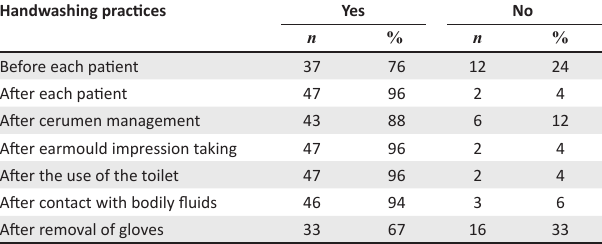
TABLE 4: Participants’ handwashing